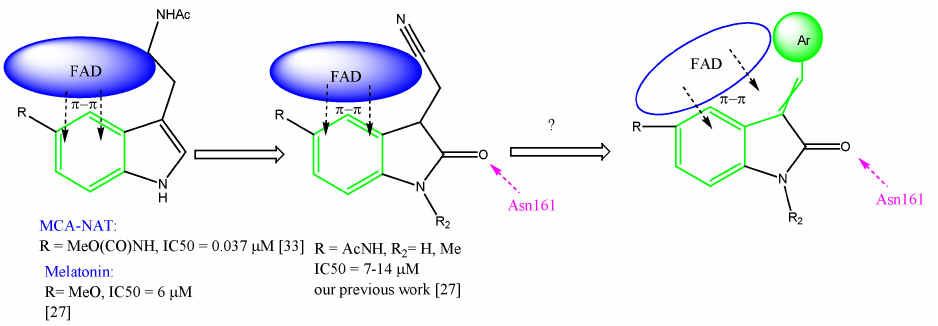
Figure 1. Proposed design of novel oxindole-based NQO2 inhibitors